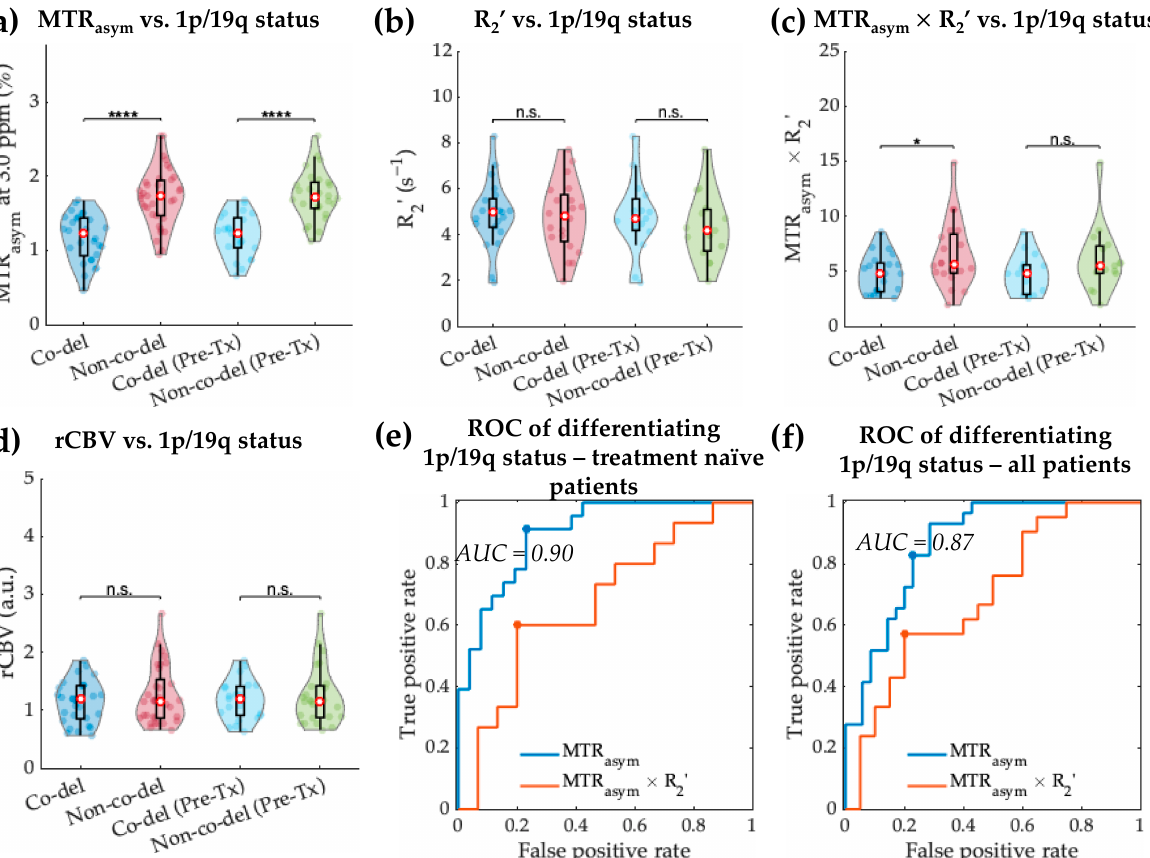
Figure 5. 1p/19q co-deletion status differentiation within IDH mutant gliomas based on MTR asym , R 2 ′ , MTR asym × R 2 ’, and rCBV. Violin plot graphs of IDH mutant 1p/19q co-deleted and non-col- deleted gliomas imaging features ( a – d ) are demonstrated for both the entire patient cohort and treatment-naïve patients. The red dots represent the median value, while the upper and lower edges of the box plots represent the 25th and 75th percentile values, respectively. The receiver operating characteristic curves for treatment-naïve patient cohort are plotted in ( e ), showing the best differentiation with MTR asym (AUC = 0.90). ROC curves for all patients are plotted in ( f ). *: p -value < 0.05; ****: p -value < 0.0001; n.s.: